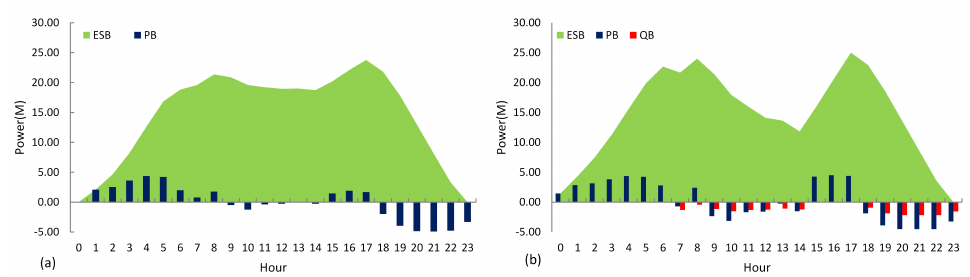
Figure 16. Energy management of the five BESS units in the 141-bus test system.